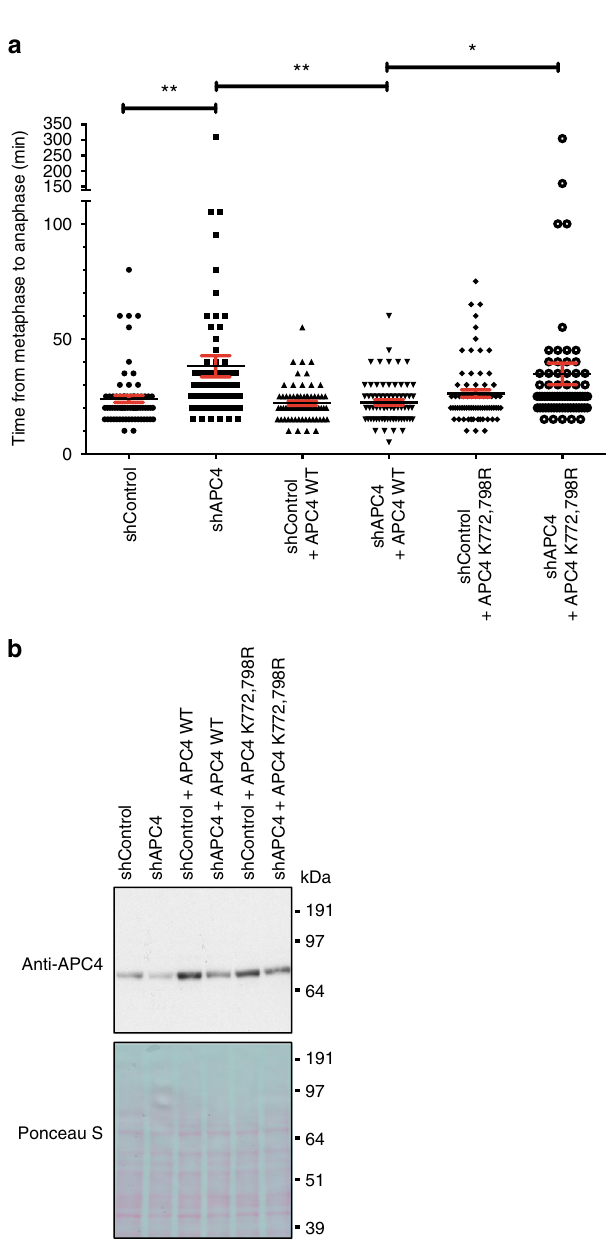
Fig. 4 Mutation of K772 and K798 abolishes the rescue of a mitotic delay after knockdown of APC4. a HeLa cells stably expressing GFP-tagged Histone 2B and containing inducible constructs of either APC4 wild type or K772,798R mutant were infected with lentivirus expressing either a control shRNA or an shRNA raised against endogenous APC4. Knockdown of the inducible APC4 constructs was abolished by introducing point mutations at the sites of shRNA binding. Two days after infection with the viruses and induction of the APC4 constructs, the time needed for mitotic progression from metaphase to anaphase onset was monitored by live cell imaging. The mean value and the SEMs are shown for 70 cells per condition and p -values were obtained via Student ’ s t -test. p -values: * p < 0.02, ** p < 0.005. b Knockdown of APC4 was con fi rmed via western blot analysis of cell lysates 2 days after infection with the lentiviruses expressing either control shRNA or shRNA against APC4. The blot was stained with Ponceau S to